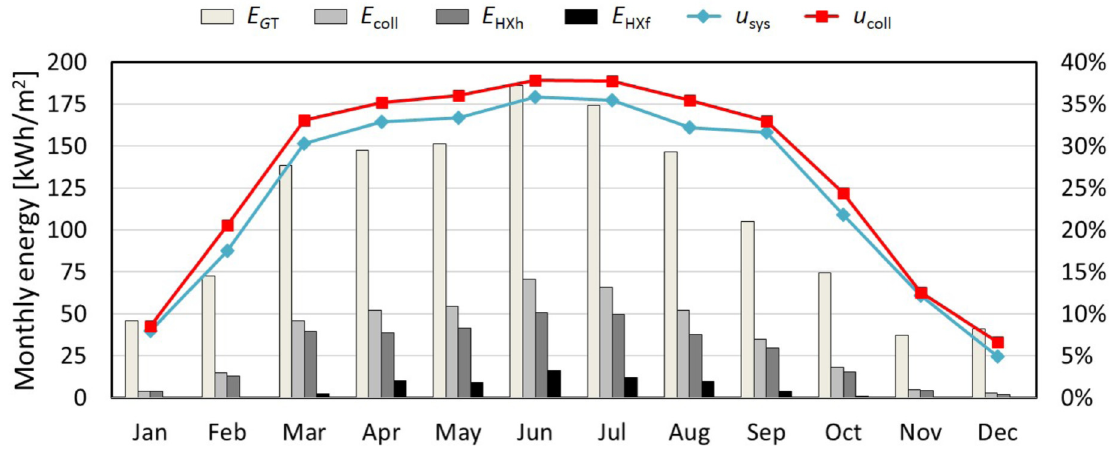
Fig. 2. Speci fi c energy output and utilization ratio by month